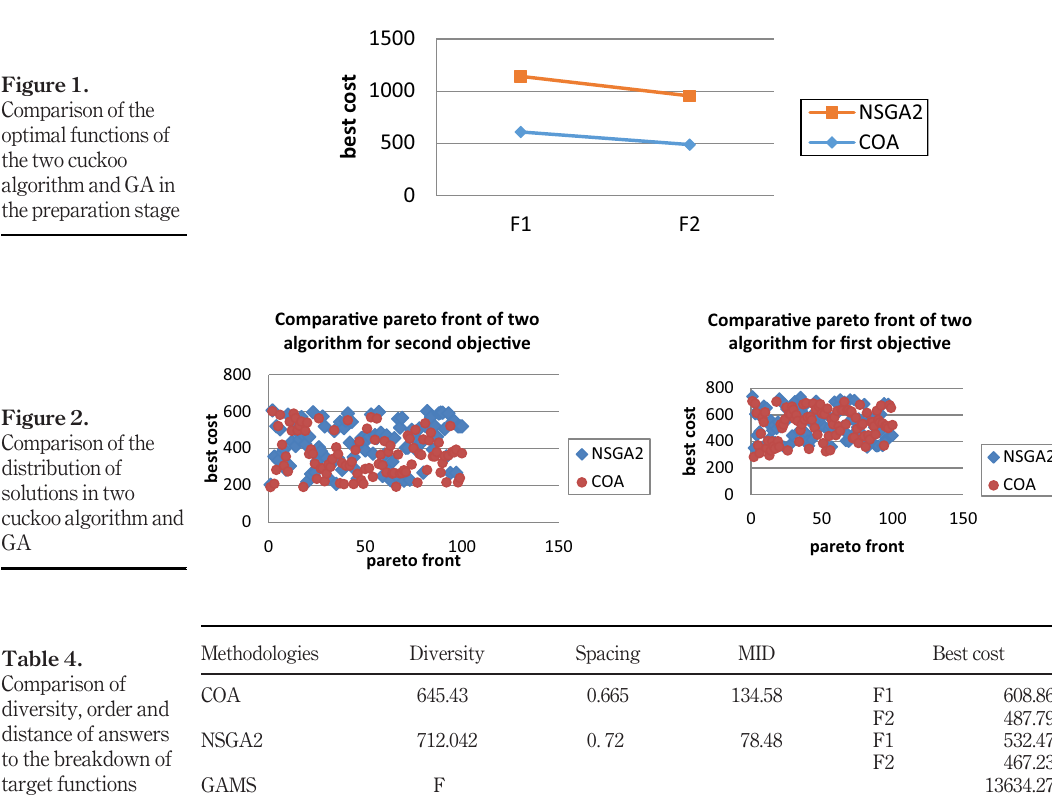
Table 4. Comparison of diversity, order and distance of answers to the breakdown